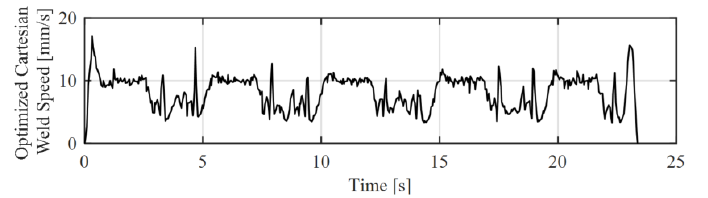
Figure 13. Resulting Cartesian Path Speed after trajectory